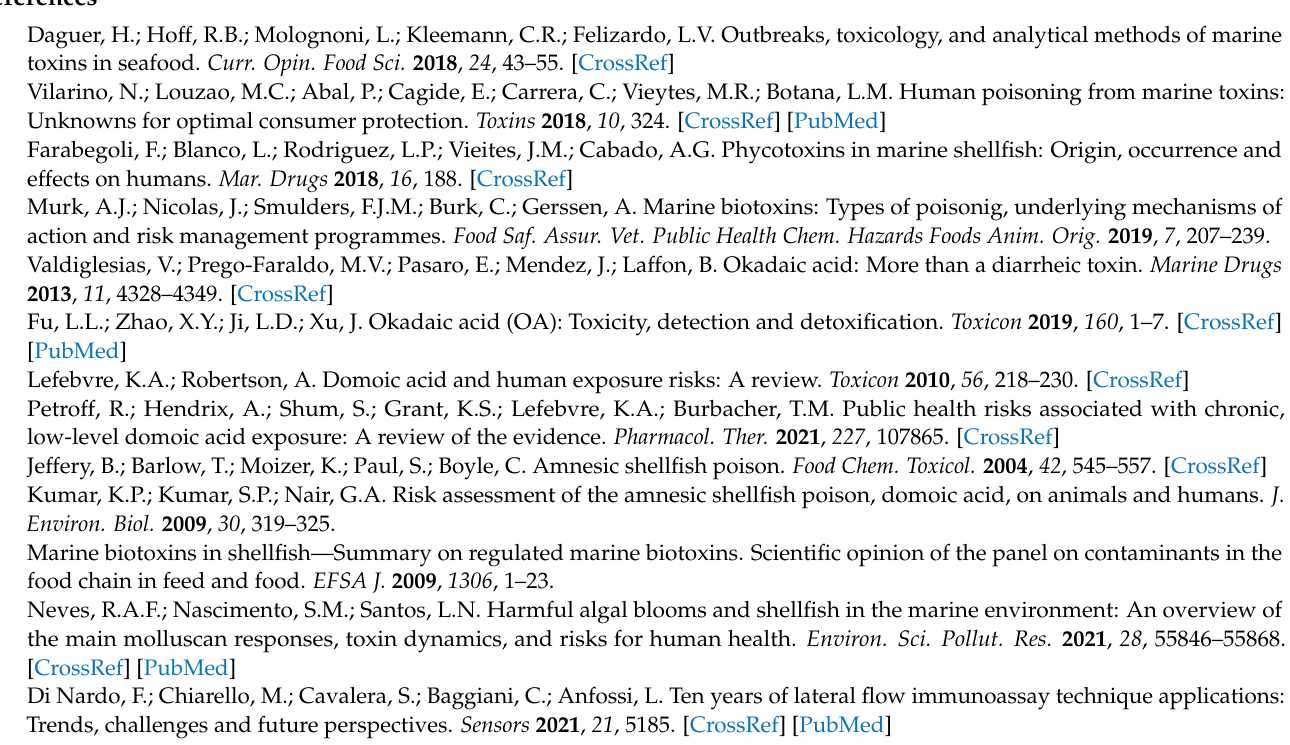
(b) in the indirect ELISA; Figure S2: Images of the test strips after the double ICA of DA and OA in seawater; Table S1: Comparison of analytical characteristics of double ICA for different methods of seawater sample preparation.; Table S2: Comparison of the analytical characteristics of double ICA with different methods of sample preparation of seawater containing Triton